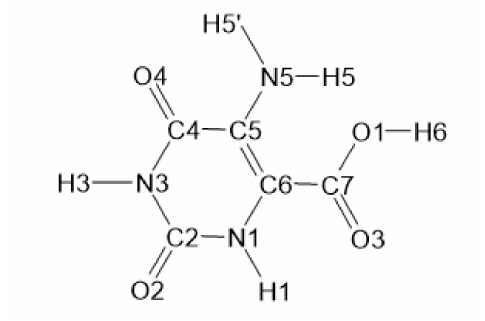
Figure 1. Chemical structure of 5-aminoorotic